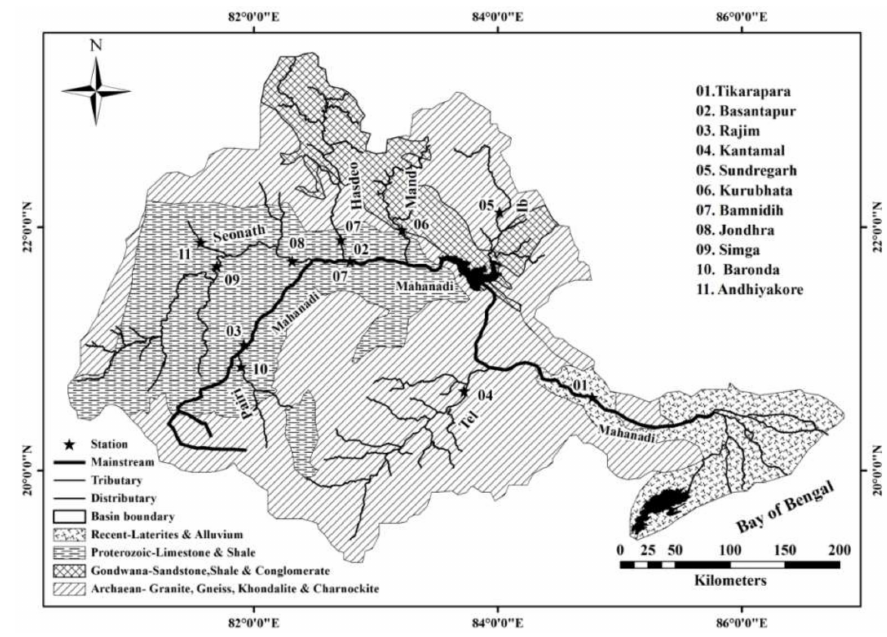
Figure 1. Location map of the MRB with eleven gauging stations. Table 1. Sub-basins and tributaries of the MRB with catchment